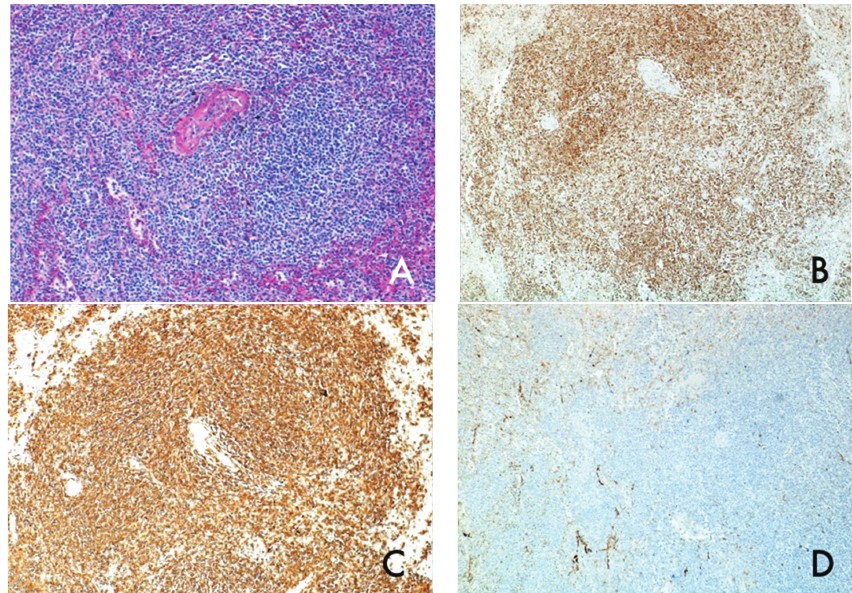
Figure 10: Marginal zone lymphoma of the spleen: (A) there is e ff acement of splenic architecture by sheets of monotonous small-to-medium size lymphocytes (hematoxylin-eosin, original magnification × 200). Immunohistochemical stains show that the lymphocytes are positive for BCL2 (B) and CD20 (C), and negative for CD10 (D) (immunoperoxidase, original magnifications × 200 ((A) through (D))).